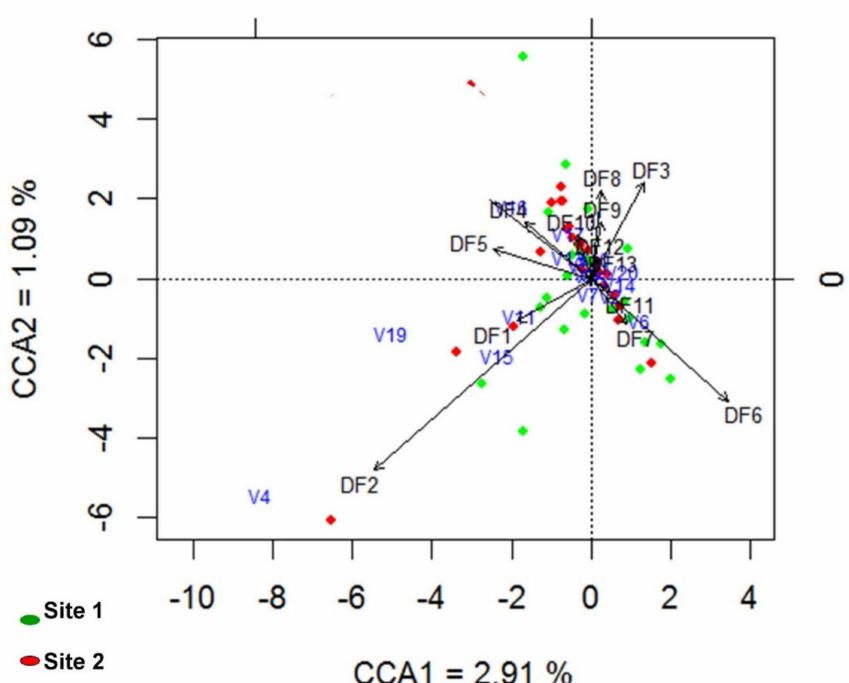
Figure 6. Scatter plot of Canonical Correspondence Analysis (CCA) representing points in green, site1, points in red, site 2. The response variables are plotted as labels (V1—2015—present/brown bear; V2—2015—present/wild boar; V3—2015—present/red fox; V4—2015—present/grey wolf; V5-2010—2015/brown bear; V6-2010—2015/wild boar; V7-2010—2015/red fox; V8-2010—2015/grey wolf; V9-2000—2010/brown bear; V10-2000—2010/wild boar; V11-2000—2010/red fox; V12-2000— 2010/grey wolf; V13-1990—2000/brown bear; V14-1990—2000/wild boar; V15-1990—2000/red fox; V16-1990—2000/grey wolf; V17-before 1990/brown bear; V18-before 1990/wild boar; V19-before 1990/red fox; V20-before 1990/grey wolf), while the explanatory variables are represented as arrows (DF1-Poaching; DF2-Banning of hunting; DF3-The park rangers do not feed the animals; DF4-There are too many wild animals compared to how much the habitat could support; DF5-The animals are accustomed to artificial feeding; DF6-Humans have invaded their habitat due to the construction of houses, roads or touristic infrastructures; DF7-Wildlife habitats offer less food due to recent deforestation actions; DF8-Wildlife are affected by the intensive exploitation of mushrooms and berries; DF9-Relocations; DF10-The presence or absence of sheepfolds; DF11-The removal of the local dumpsite; DF12-Forest privatization leading to higher management intensities/shorter rotation periods; DF13-Lack of herbivores or natural